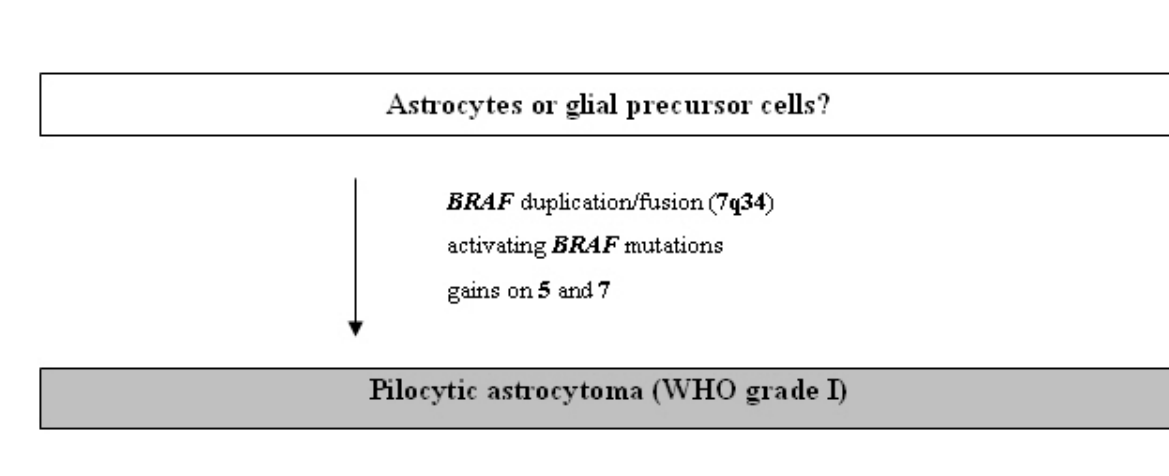
Figure 2. Schematic representation of the molecular pathogenesis of pilocytic